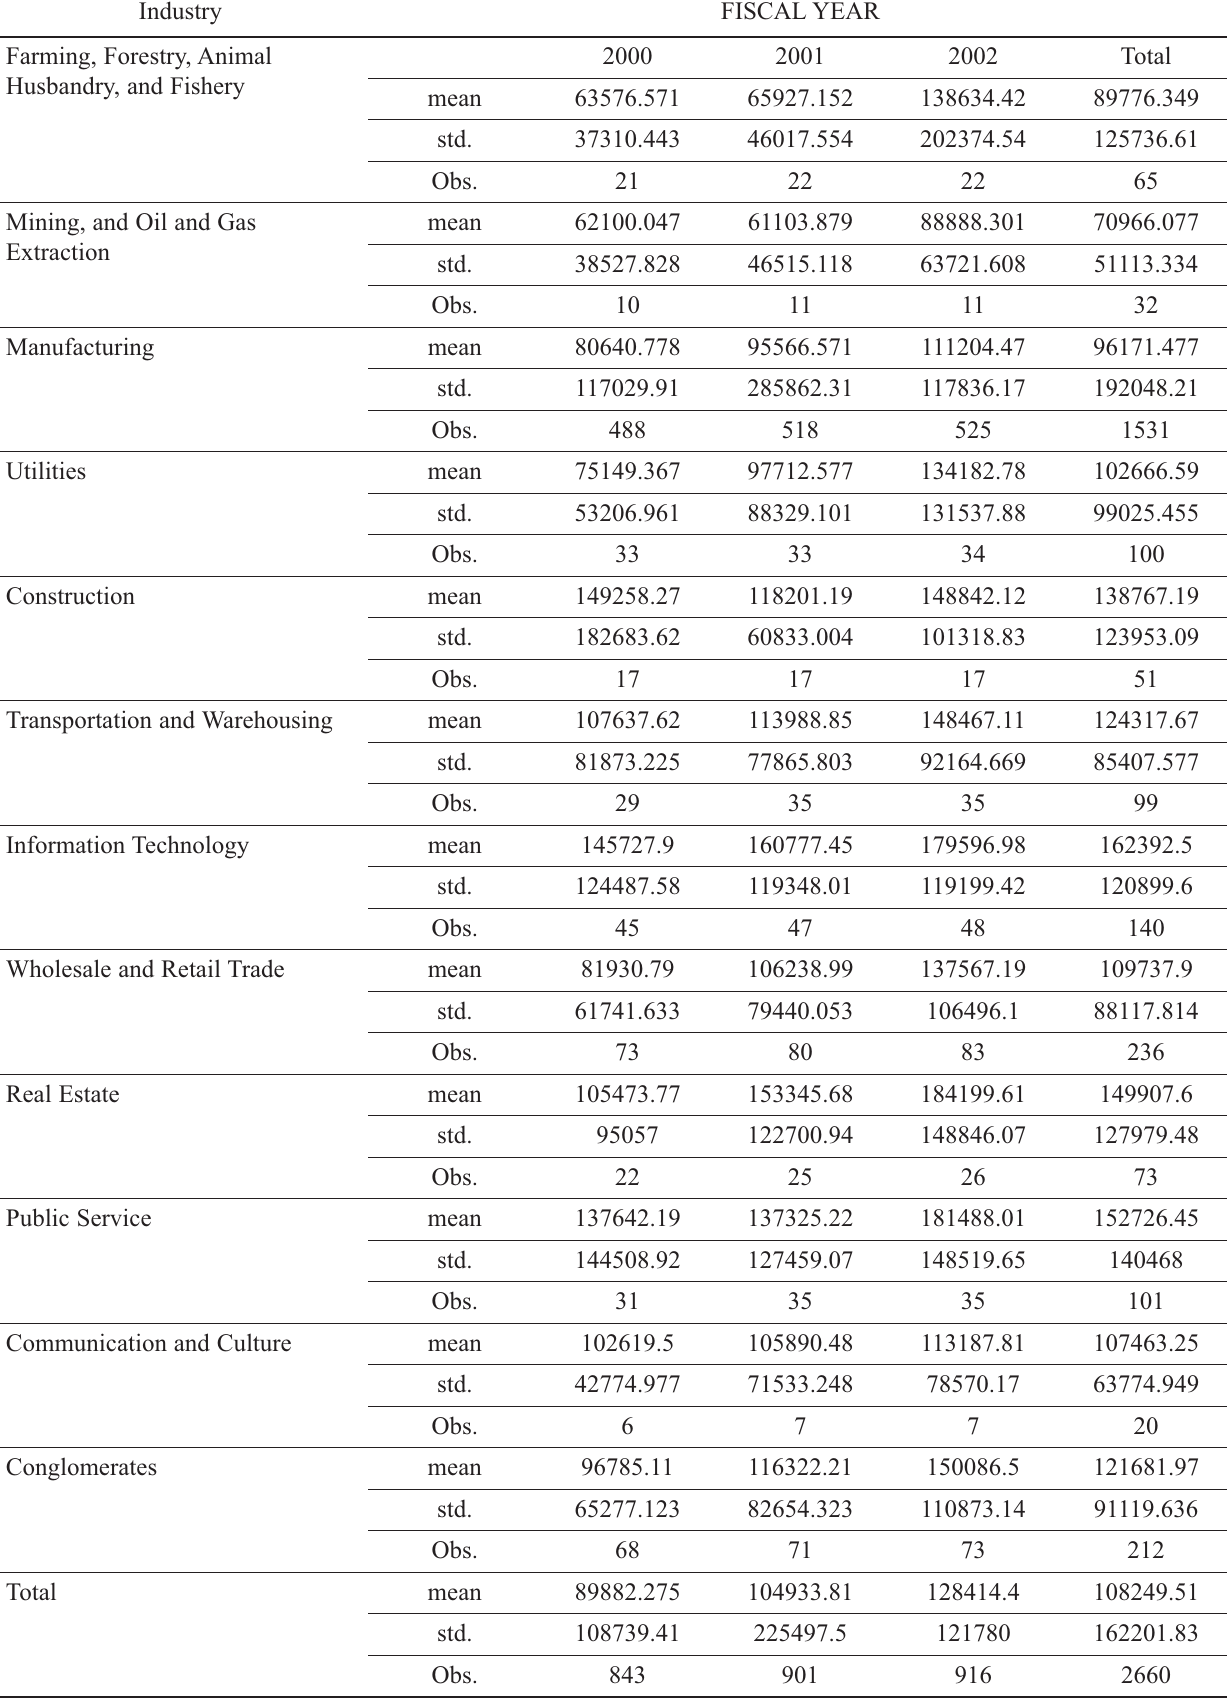
Table 4. Summary Statistics of CEO Compensation by Industry and Year (Unit: RMB yuan)